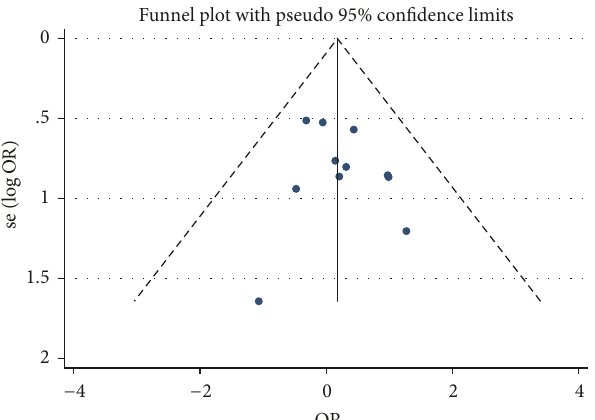
Figure 7: Funnel plot of studies included in Figure 6. Dots represent the results of each study. The funnel plot was visually examined, showing symmetrical characteristic of eleven trials reporting the adverse events. There was no asymmetry and statistical evidence of publication bias among the included